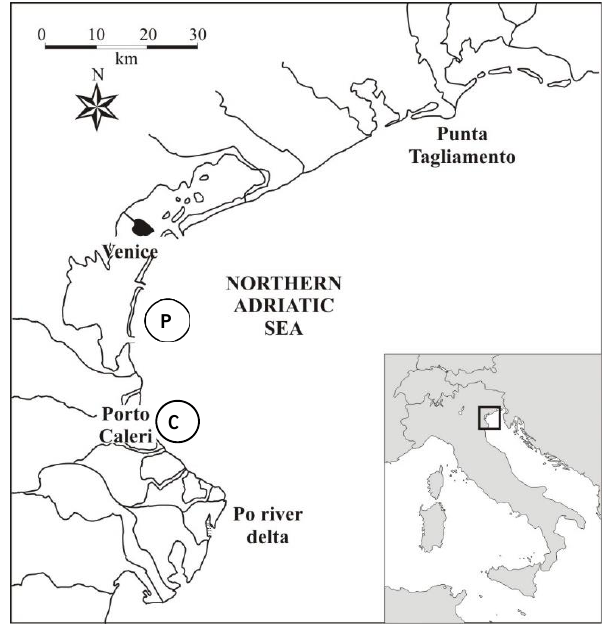
Figure 1. Sites of net bag collectors deployment in North-Western Adriatic Sea: Pellestrina (P) and Caleri (C).